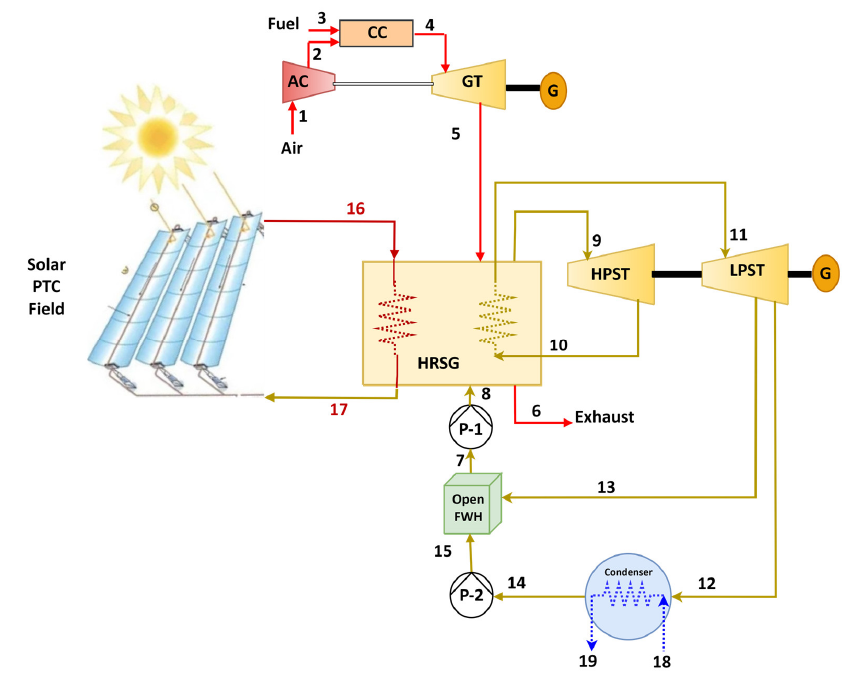
Figure 2. Schematic diagram of the Integrated Solar Combined Cycle (ISCC). Table 2. Operation conditions used for the ISCC system [31,32].